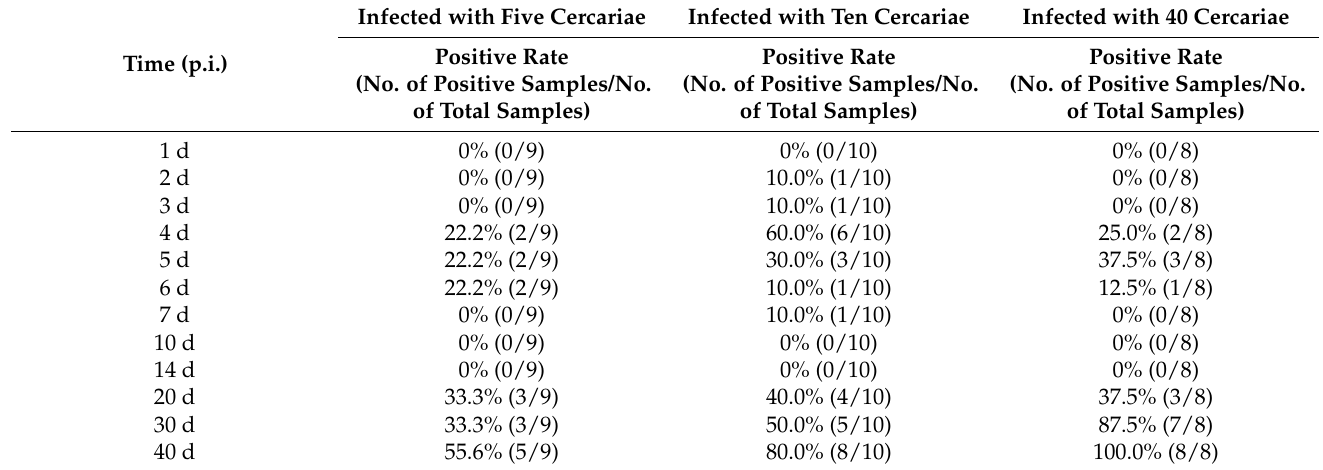
Table 5. Detection efficacy of the RPA–LFD assay for mouse schistosomiasis japonica at different stages. Infected with Five Time (p.i.)